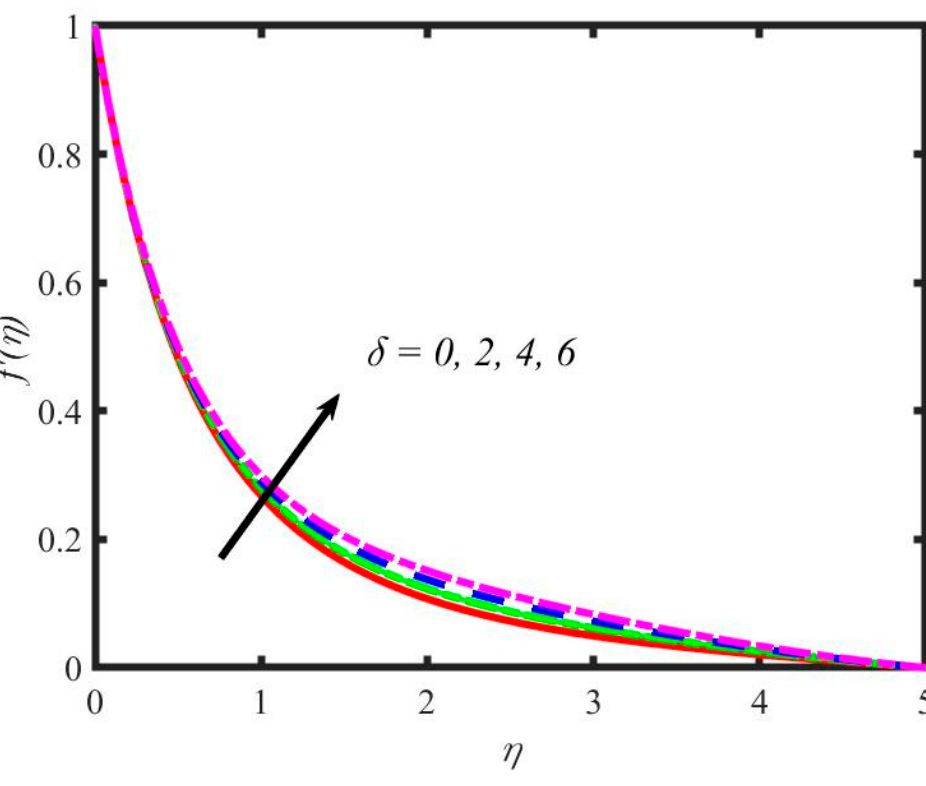
Figure 4. Variations in velocity for microorganisms’ parameter.